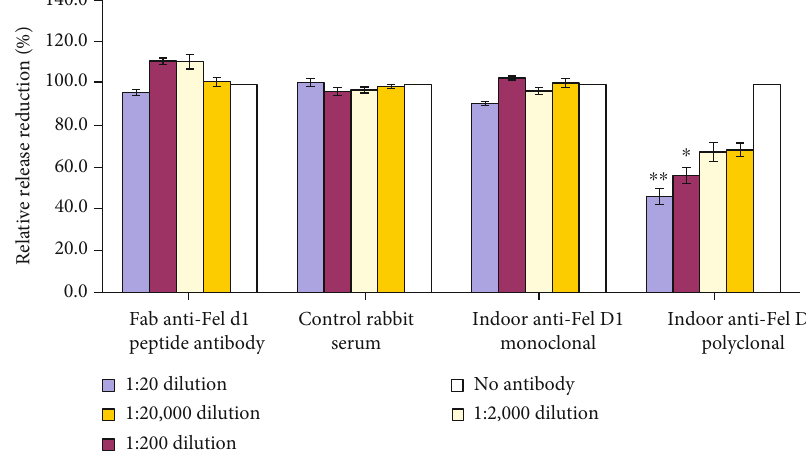
Figure 2: Beta-hexosaminidase release assay with multiple rabbit Fel d1 antibodies and control serum. “ Indoor Poly ” dose-dependently reduced relative mediator release in the rat basophil assay compared to a “ no-antibody ” control. Control rabbit serum, FGI, and Fel d1- speci fi c monoclonal (clone 6F9) had no e ff ect on relative mediator release. ∗ Signi fi cantly di ff erent from control ( p < 0 : 001 ). ∗∗ Signi fi cantly di ff erent from control ( p < 0 : 05